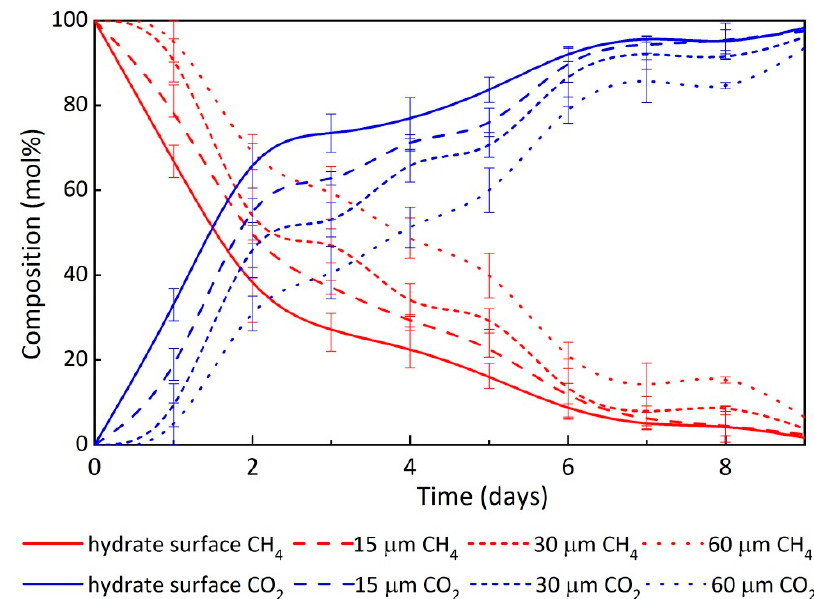
Figure 6. Changes in the average composition in mol% of the hydrate phase at defined depths over time after the initial CH 4 hydrate was exposed to a CO 2 gas phase. The standard deviation of the average composition in three repeated CH 4 –CO 2 exchange experiments were used for the descriptive error bars.